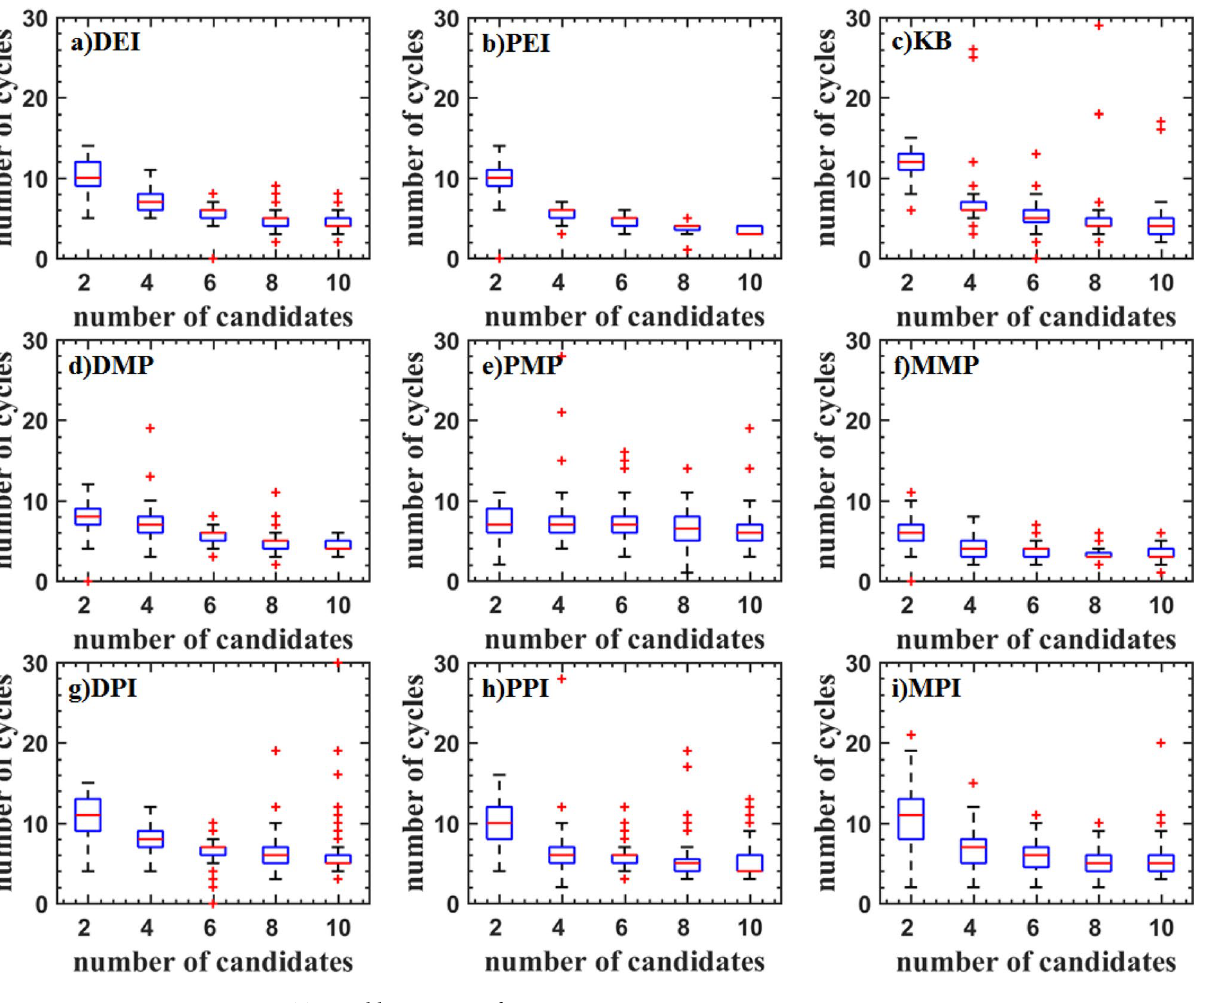
Figure 5. Test problems: Branin